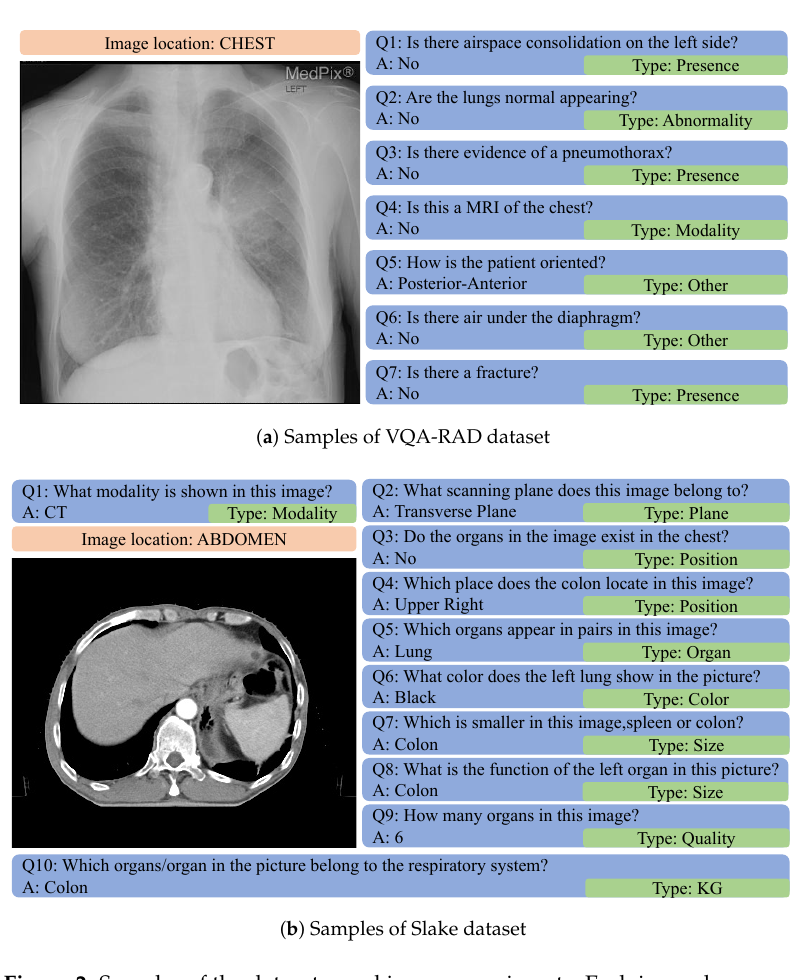
Figure 2. Samples of the datasets used in our experiments. Each image has several different types of QA pairs. Table 1. Details of the dataset we use after